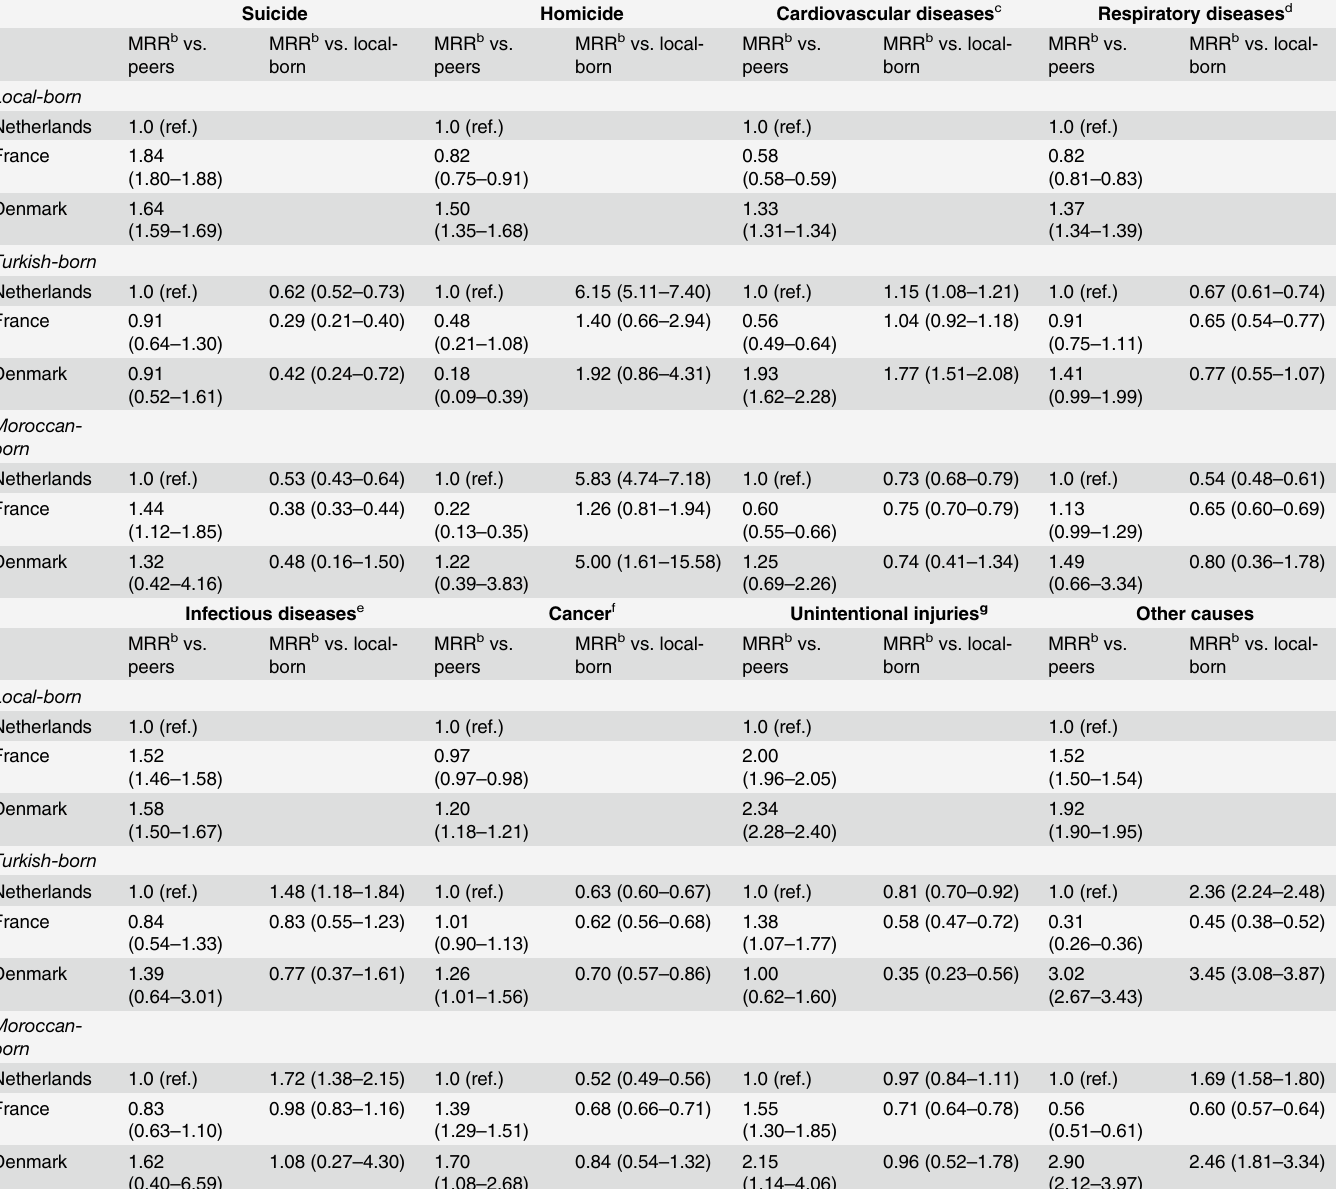
Table 4. Cause-specific mortality rate ratios (MRR) comparing with the local-born population a and with peers in the Netherlands among Turkish- and Moroccan-born, both men and